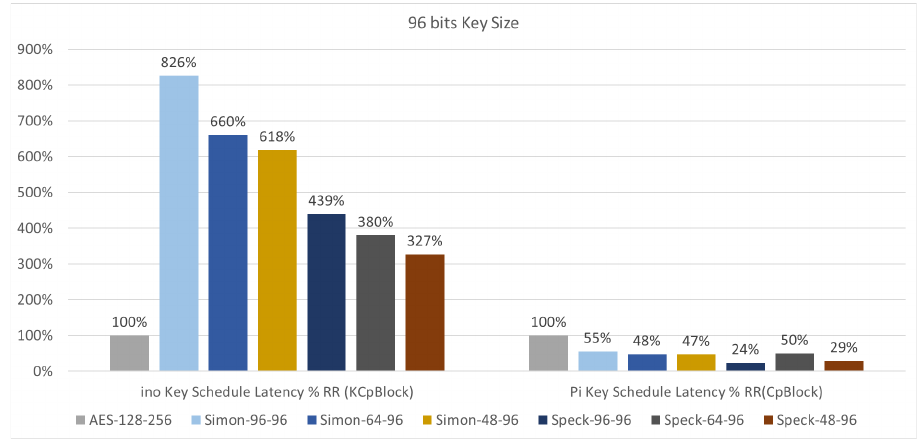
Figure 21. Group of 96-bits key size algorithms measuring key schedule speed latency with respect to RR% in UNO versus